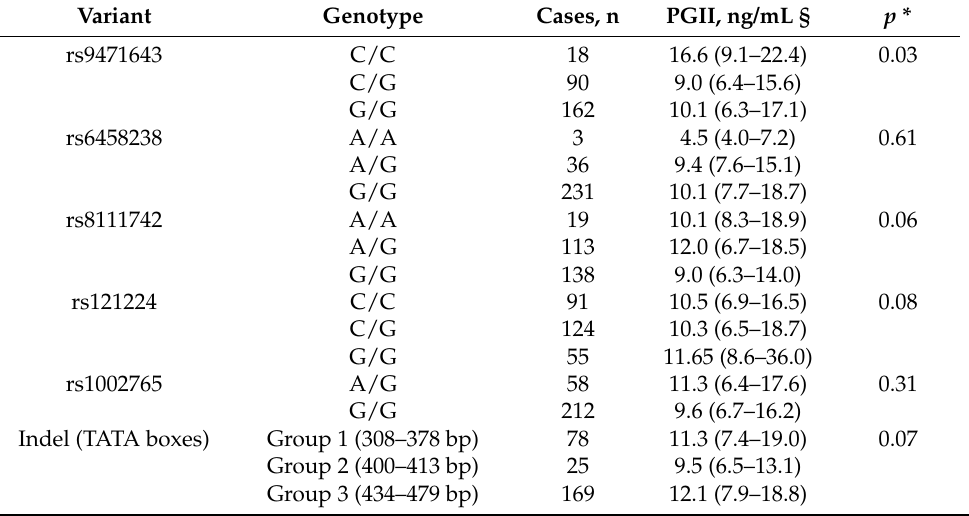
Table 6. Association of genotype with serum PGII levels in all 270 study subjects.